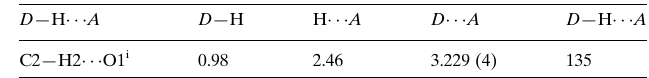
Hydrogen-bond geometry (A˚ , (cid:2)